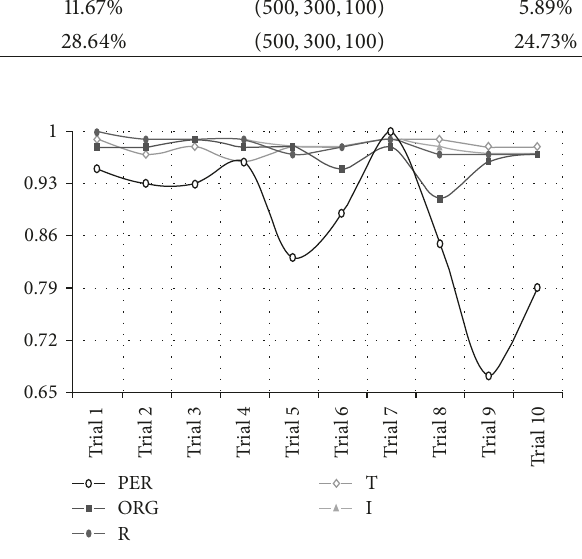
Figure 4: Entity accuracy rate